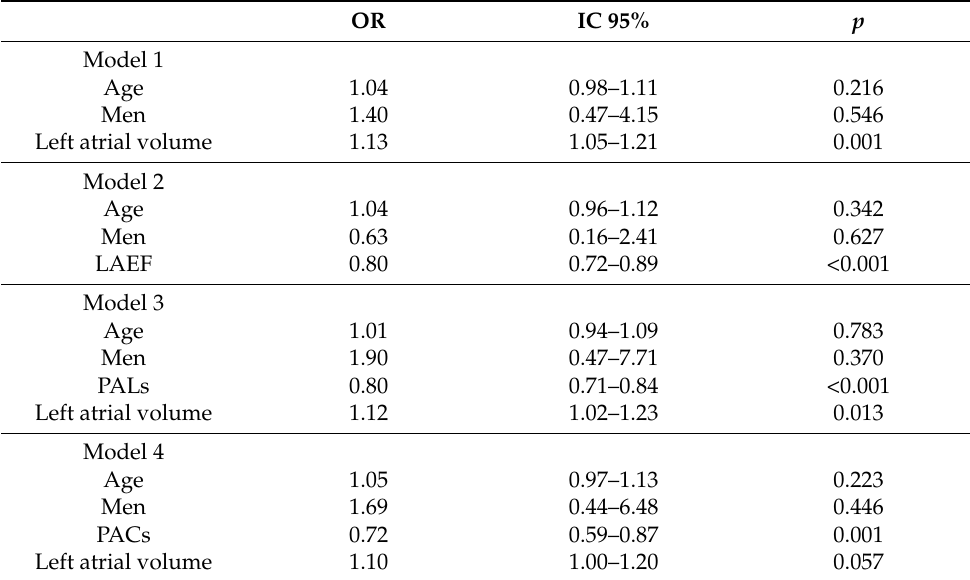
Table 2. Multivariate logistic regression analysis models to detect atrial fibrillation after a cryptogenic